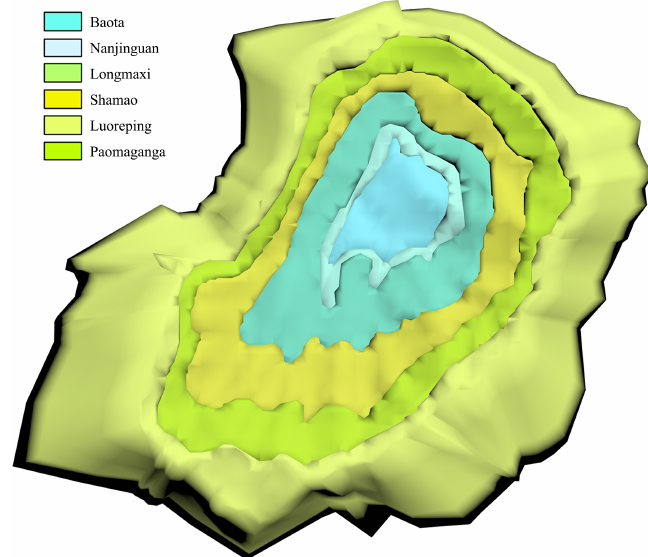
Figure 12. The model of Wulongshan dome.